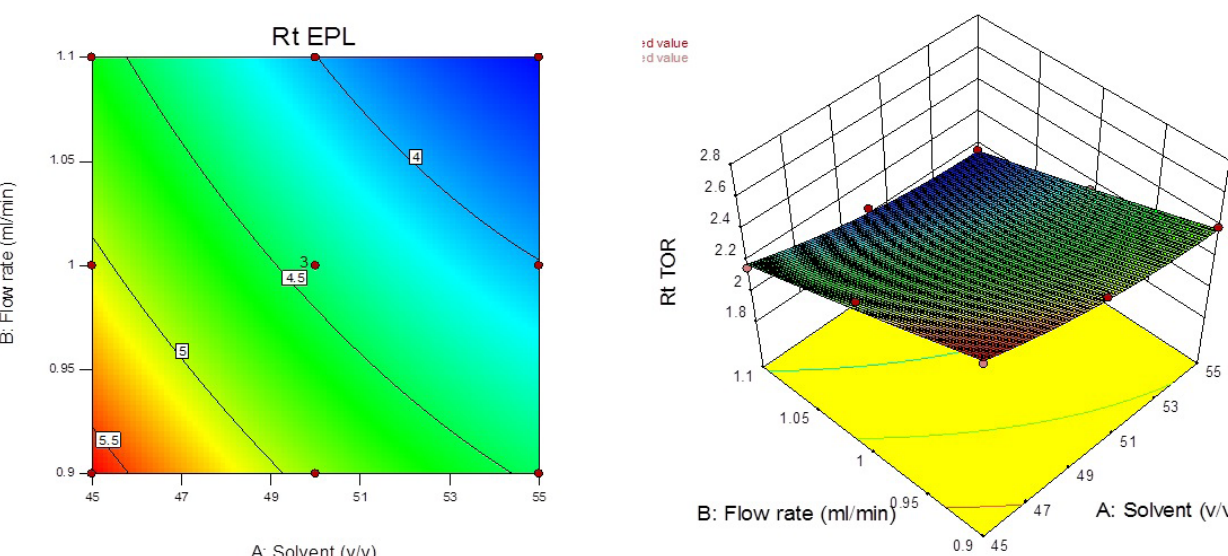
) and flow rate (X 1